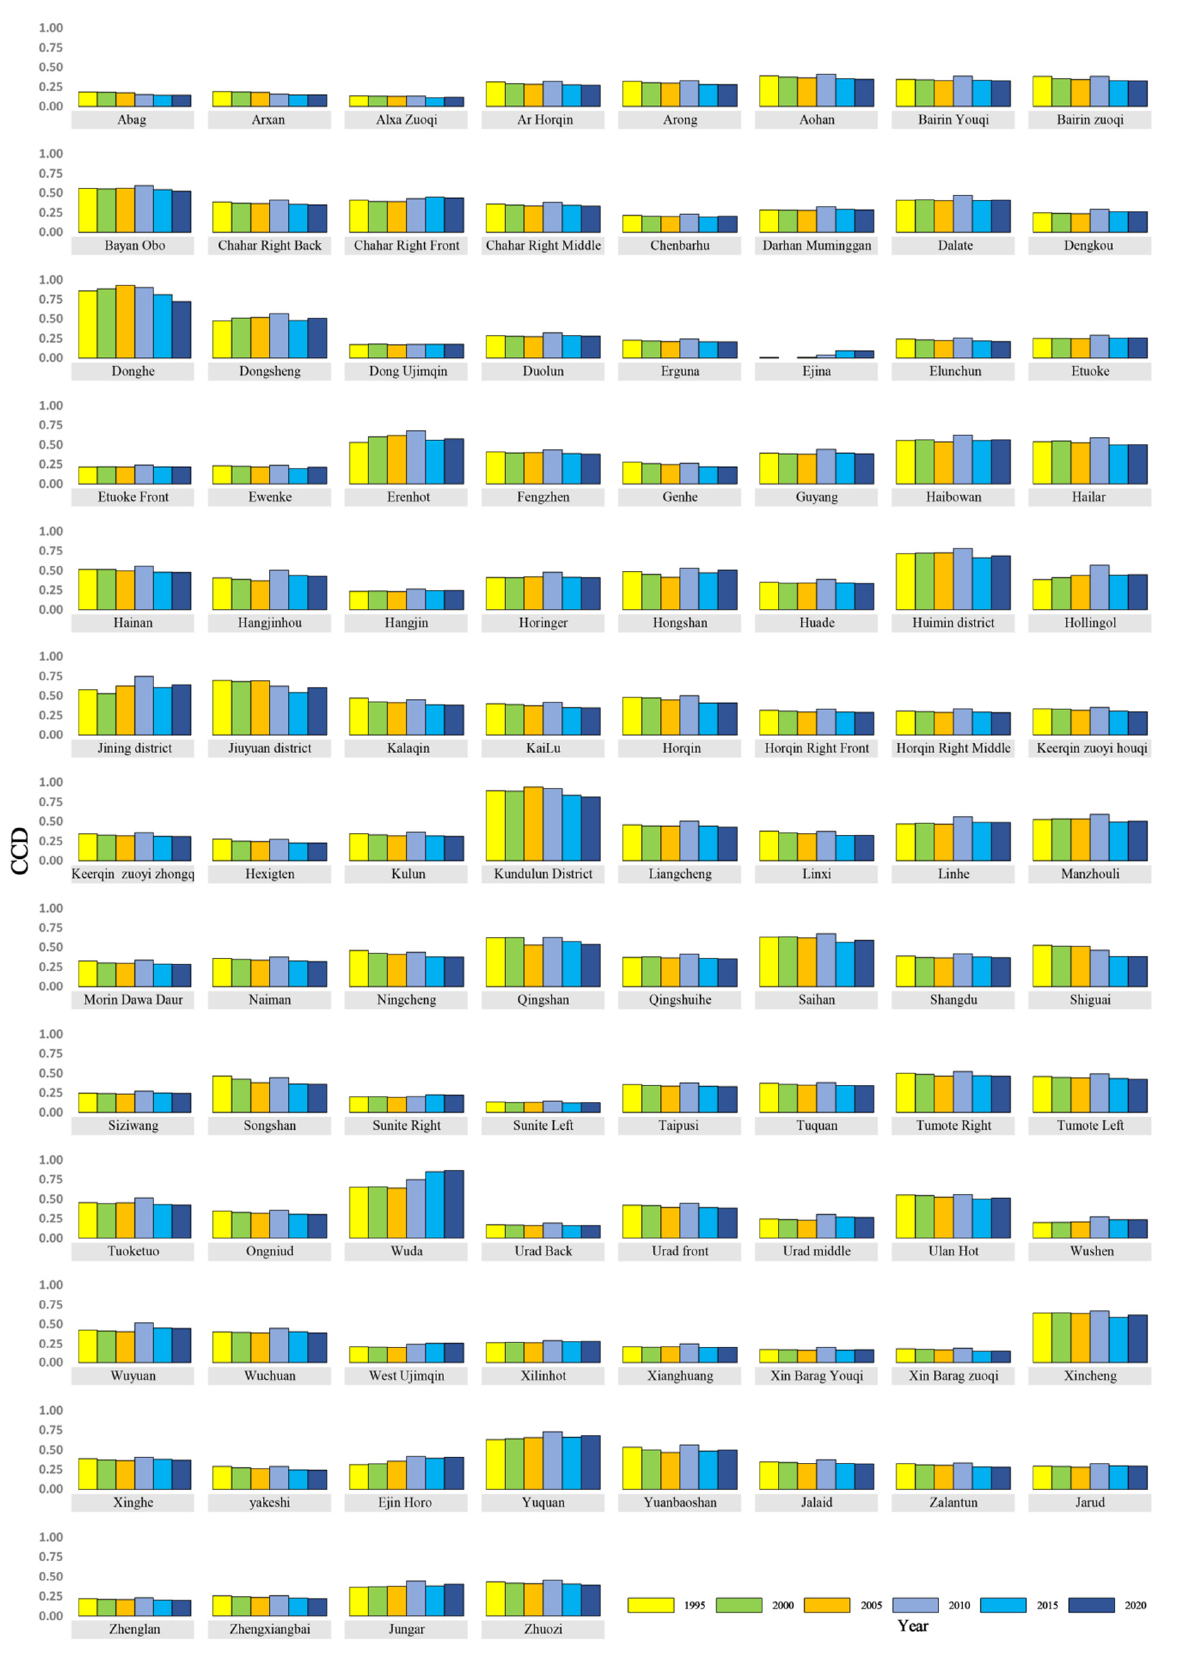
Figure 8. The temporal changes of the CCD between ESs and urbanization by county.